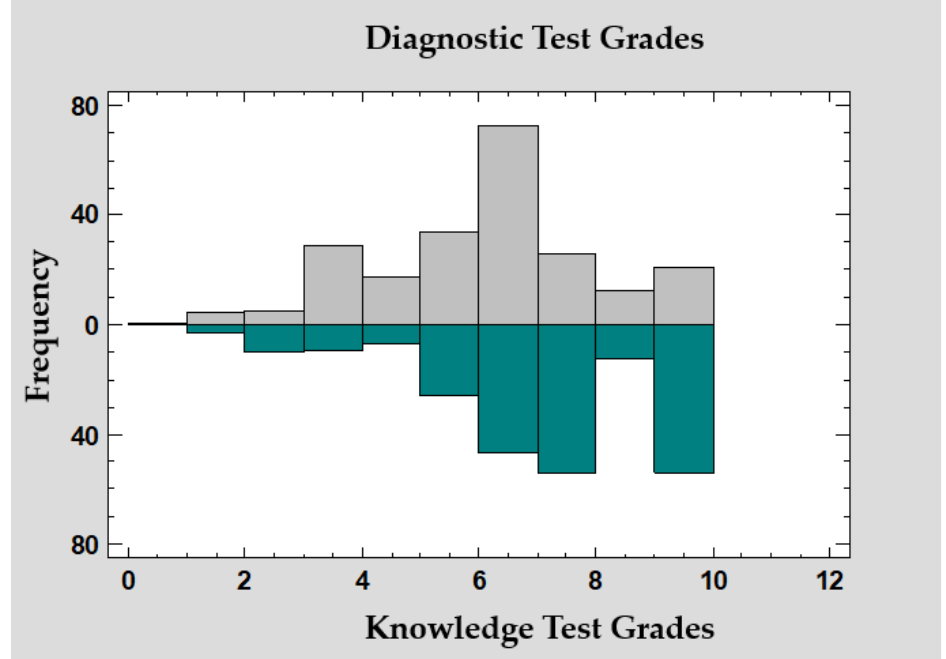
Figure 9. Frequency distribution of grades in the Diagnostic and Knowledge Tests.